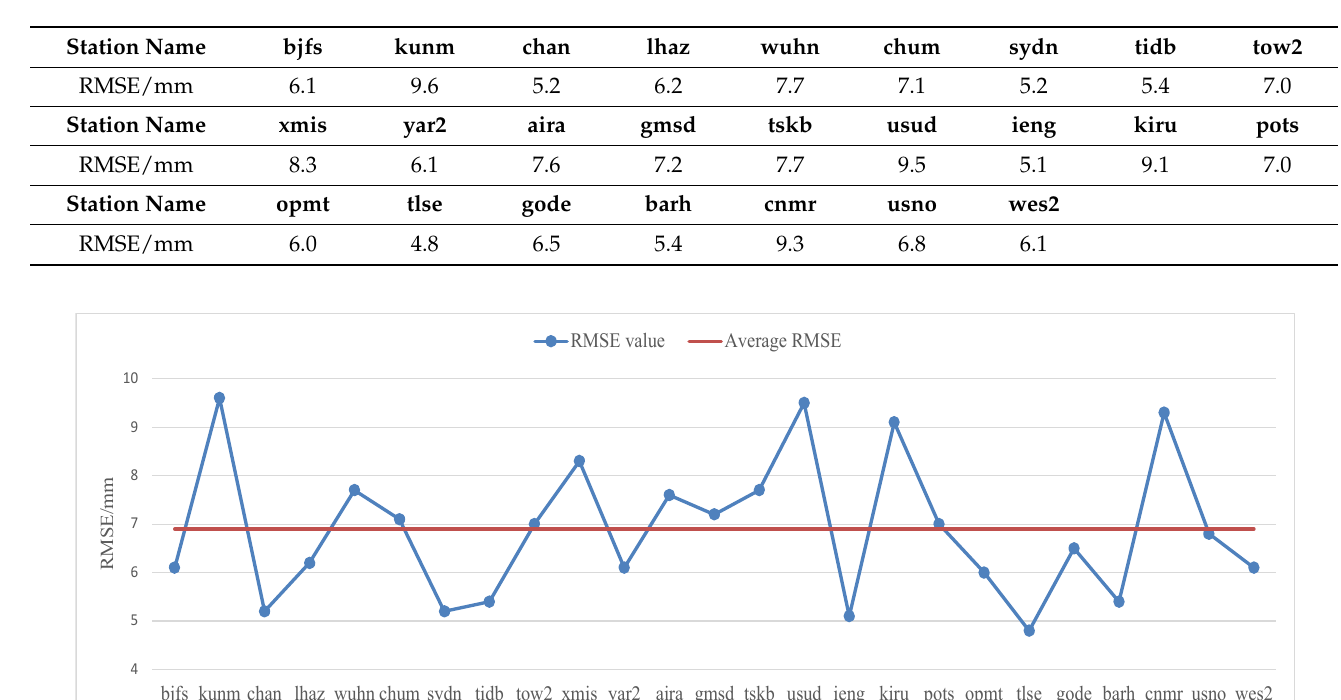
Figure 3. Distribution of RMSE indicators for 25 CORS elevation nonlinear LS period modeling around the world. Table 5. Corresponding amplitude values (mm) of the main periodic terms of the elevation nonlinear LS modeling of 25 CORS stations around the